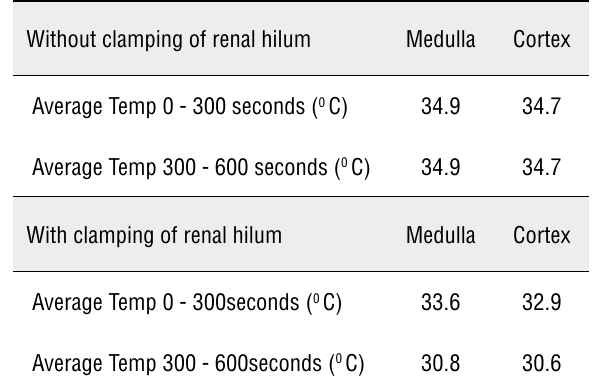
Table 2 - Retrograde cooling with and without hilar clamping for infusion rates greater than 600